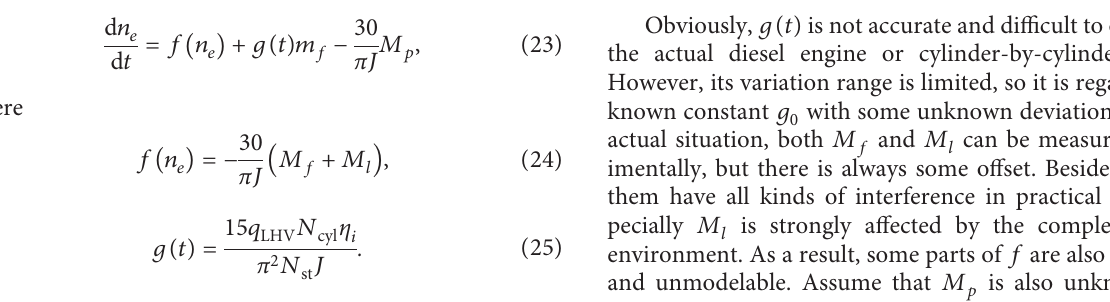
Figure 4: The speed responses of the original MVEM and the new cylinder-by-cylinder MVEM with the same fuel injection input. (a) The speed responses. (b) The fuel injection